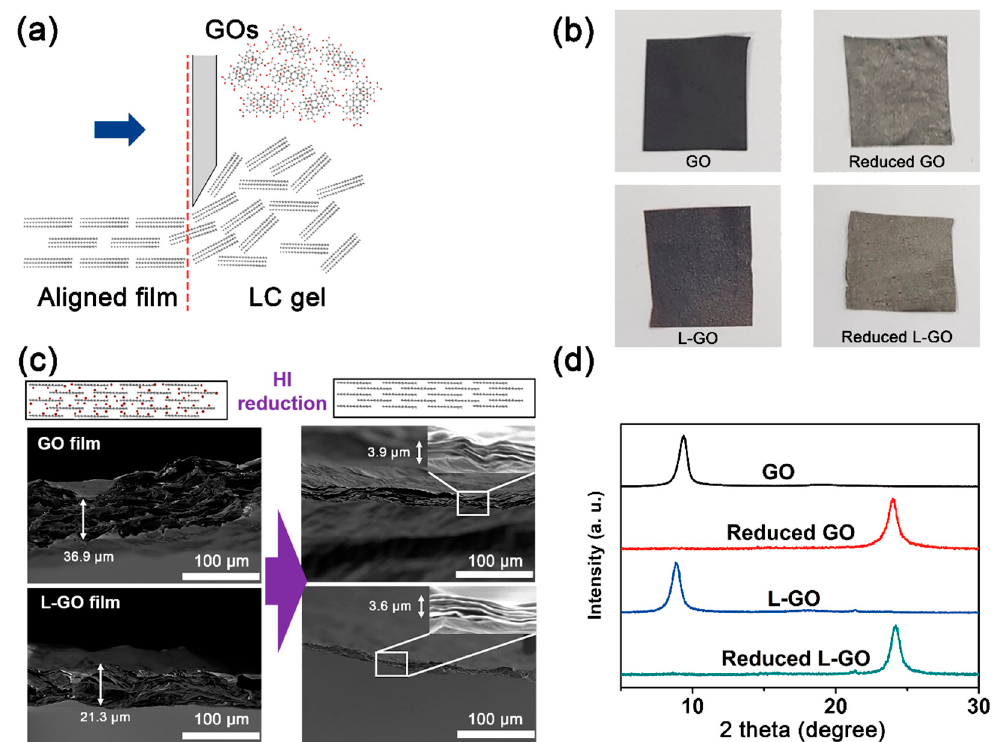
Figure 3. ( a ) Schematic of preparation of graphene-based films from liquid crystal GO suspensions. Gray and red circles indicate carbon atoms and functional groups, respectively. ( b ) Photograph of GO and L-GO films before and after reduction. ( c ) Structural change in graphene-based films by HI reduction: schematic illustration (top), and cross-sectional SEM images (bottom). Scale bars are 100 µ m, and insets are high magnification ( × 10,000) images of the regions marked with white rectangles. ( d ) XRD spectra of GO and L-GO films before and after hydrogen iodide (HI) reduction.